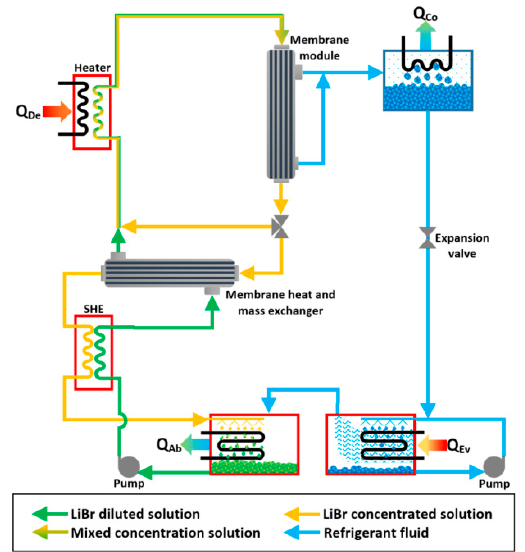
Figure 10. Membrane absorption system proposed by Hong et al. [131].